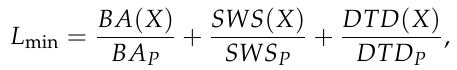
Table 4. Optimization of weight coefficient for multi−mode switching rules.